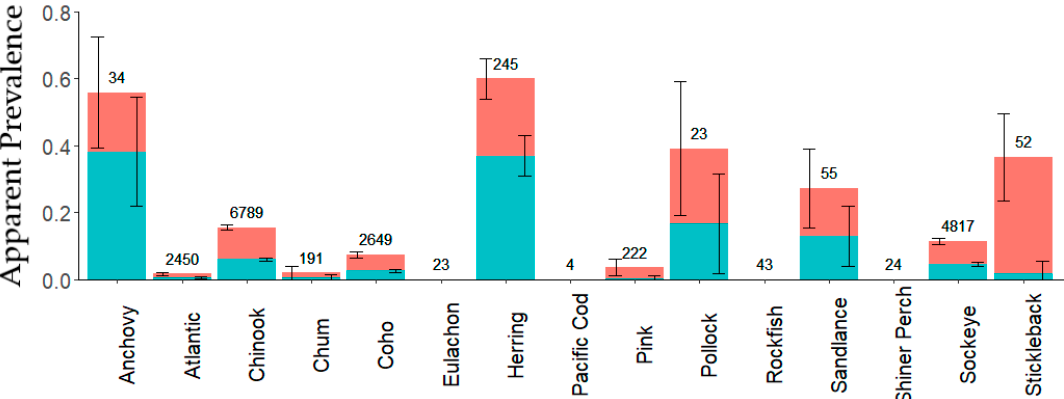
Figure 2. Apparent ENV prevalence in mixed tissue smolt samples by species. Error bars indicate 95% confidence intervals. Blue bars indicate proportions with limit of detection (LOD) criteria applied and coral bars indicate proportions without LOD criteria applied. Values indicate sample sizes for each species.